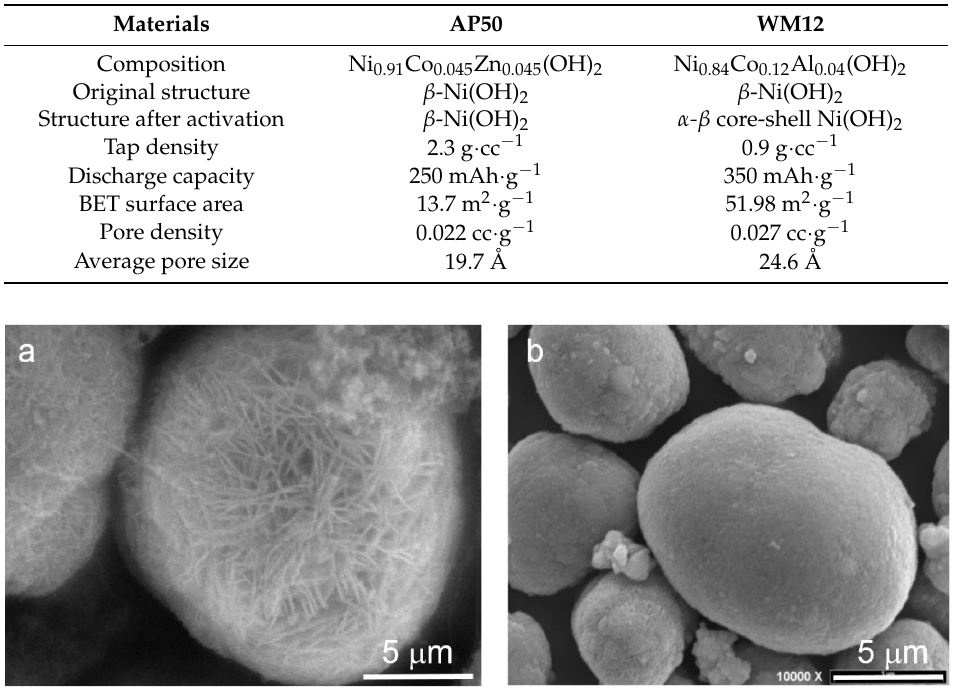
Figure 3. Half-cell capacities obtained at a discharge current of 30 mA·g − 1 for WM12 and AP50.